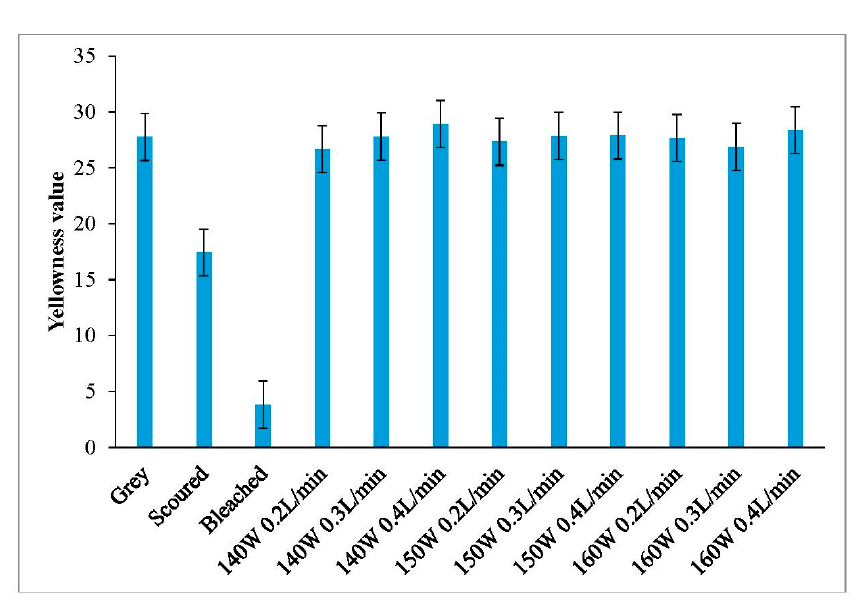
Figure 6. Dispersion size of interlock fabric.